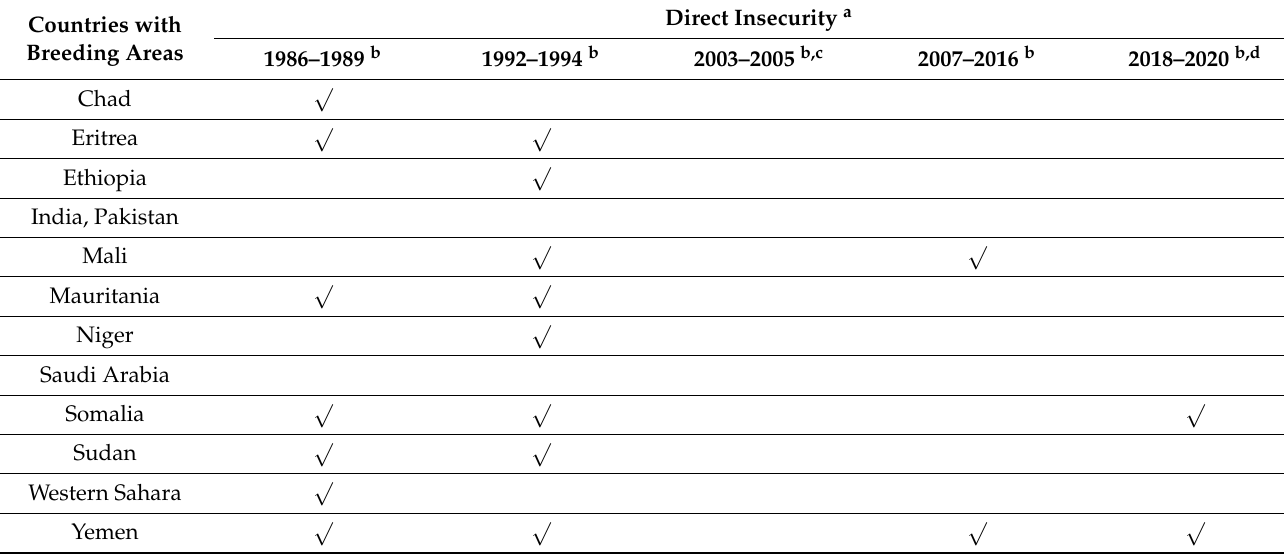
Table 1. Thirteen countries with major desert locust breeding areas, and where direct insecurity occurred during different time periods [4–8,14,15,121–138].